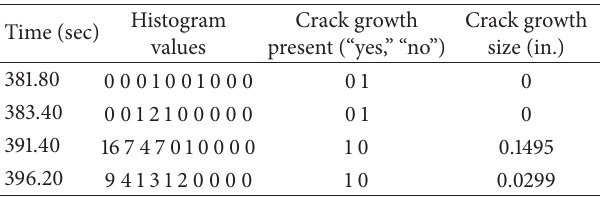
Table 1: Example data sets of histogram values and respective crack growth sizes. Time listed is for the start of the time